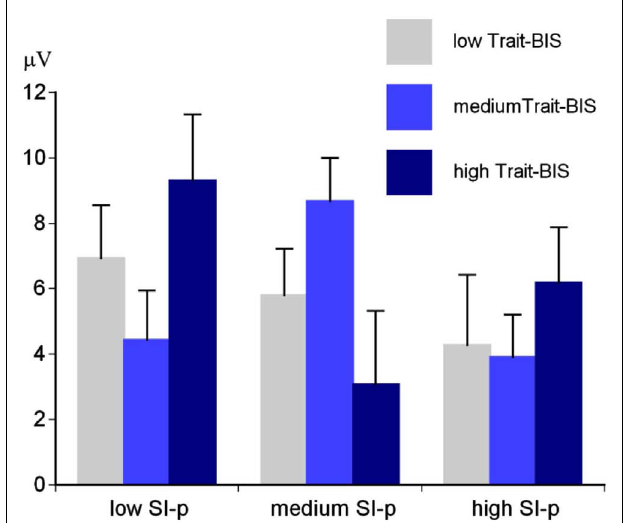
FIGURE 5 | Early baseline-to-peak P3 amplitude for SI-perpetrator (SI-p) scores × Trait-BIS scores (lowTrait-BIS/low SI-p: N = 18;